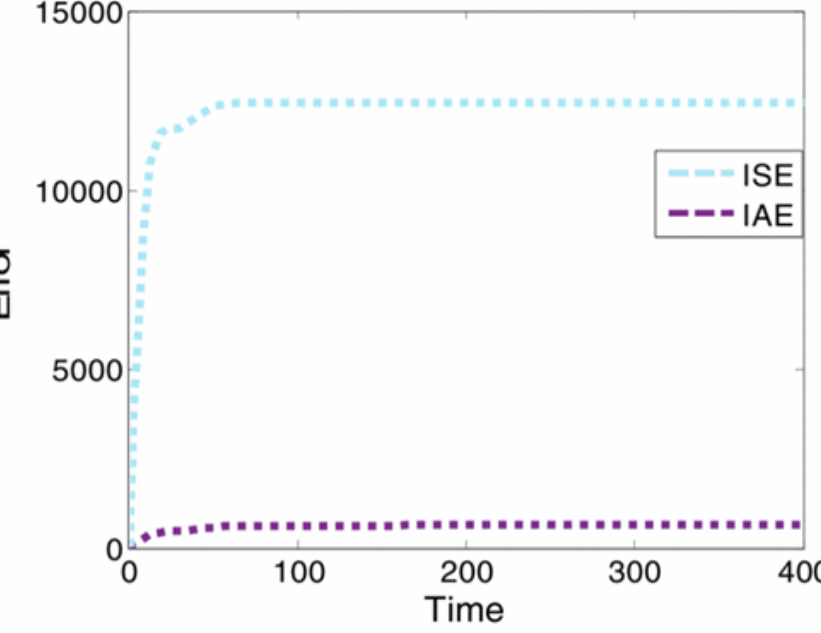
Figure 9. Ambulance output comparison plot of PID Controller and ga in terms of time and temperature.